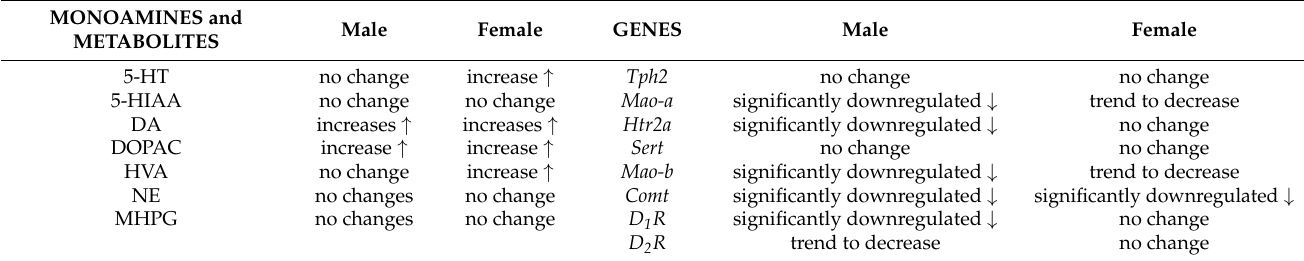
Table 1. Summary of the monoamine levels and gene expression